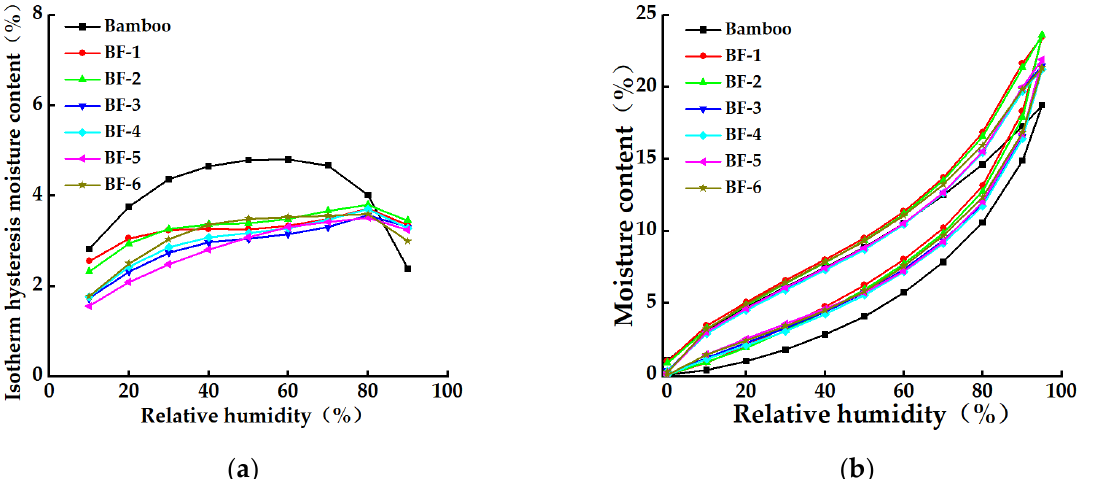
Figure 7. Moisture absorption–desorption curve of bamboo fibers with different opening times. ( a ) Moisture absorption–desorption curve. ( b ) Moisture absorption hysteresis curve.